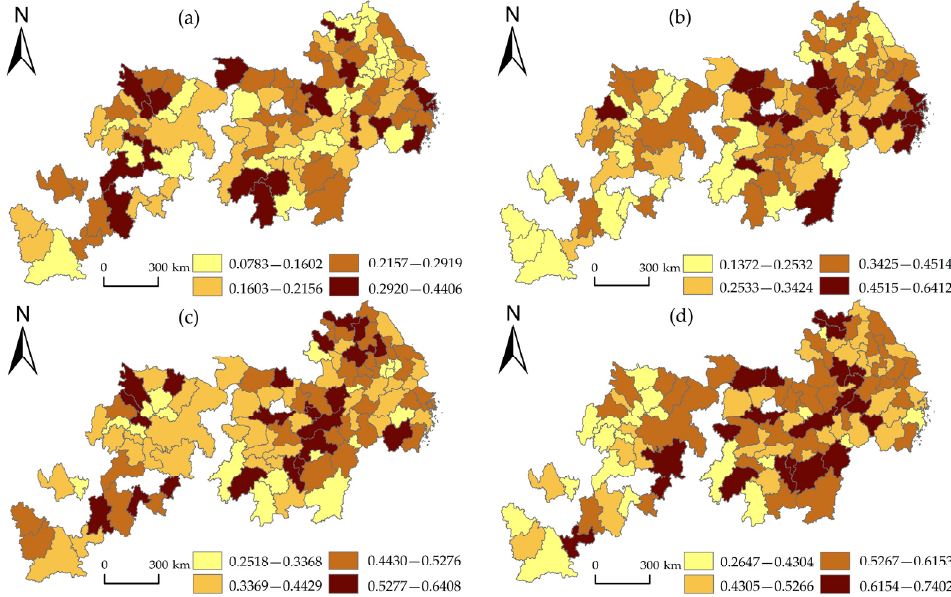
Figure 4. Spatial differentiation of the industrial integration. ( a ) The industrial integration in 2005; ( b ) the industrial integration in 2009; ( c ) the industrial integration in 2014; ( d ) the industrial integration in 2019.